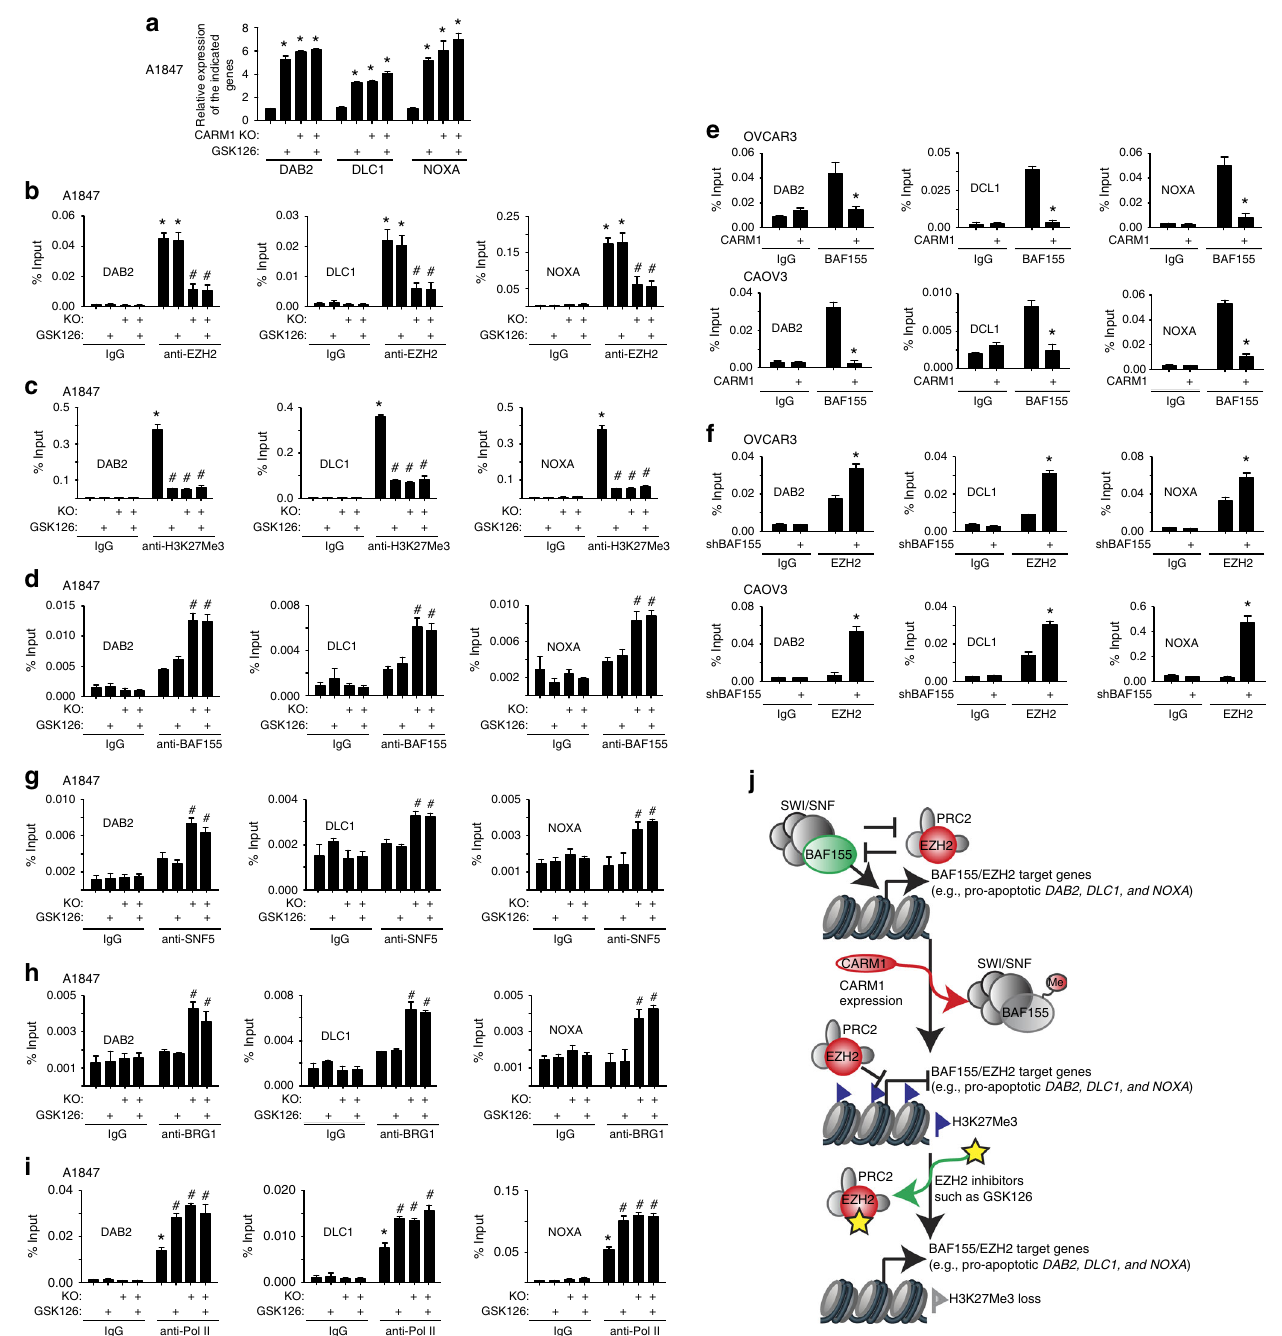
Fig. 4 CARM1 regulates the antagonism between EZH2 and BAF155 at the promoters of EZH2/BAF155 target genes. a Parental control and CARM1 knockout A1847 cells were treated with 10 μ M GSK126 or vehicle controls. mRNA expression of the indicated genes was determined by qRT-PCR. * P < 0.002 compared with parental controls. b – d Parental control and CARM1 knockout A1847 cells were treated with 10 μ M GSK126 or vehicle DMSO controls. The cells were subjected to ChIP analysis using anti-EZH2 ( b ), anti-H3K27Me3 ( c ), or anti-BAF155 ( d ) antibodies. * P < 0.001 compared with IgG controls and # P < 0.001 compared with parental controls. e The indicated CARM1-low cells with or without ectopic CARM1 expression were subjected to ChIP analysis using an anti-EZH2 antibody or an isotype-matched IgG control. * P < 0.05 compared with vector controls. f The indicated CARM1-low cells with or without shBAF155 expression were subjected to ChIP analysis using an anti-BAF155 antibody or an isotype-matched IgG control. * P < 0.03 compared with shControls. g – i Parental control and CARM1 knockout A1847 cells were treated with 10 μ M GSK126 or vehicle DMSO controls. The cells were subjected to ChIP analysis using anti-SNF5 ( g ), anti-BRG1 ( h ), or anti-RNA Pol II ( i ) antibodies. ChIP products were subjected to qPCR analysis using primers speci fi c for the promoter regions of the human DAB2 , DLC1 , and NOXA genes. * P < 0.001 compared with IgG controls and # P < 0.001 compared with parental controls. j Model proposed for the molecular basis of the selectivity against CARM1 expression by EZH2 inhibition. Means of three independent experiments with SEM. P -values are from two-tailed t